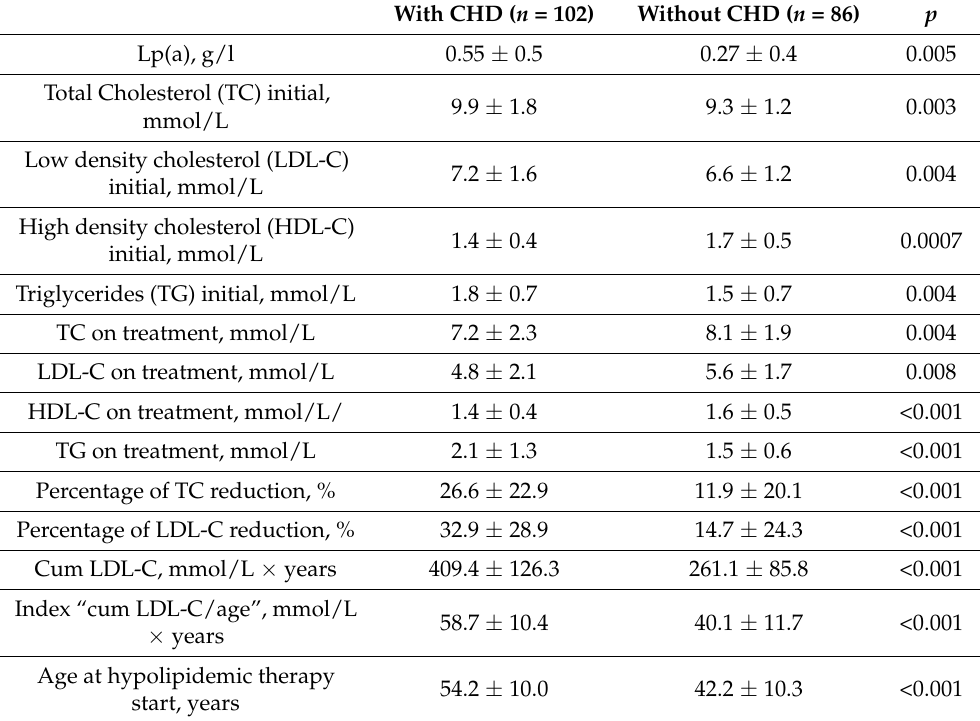
Table 2. Lipid risk factors and CHD development in FH